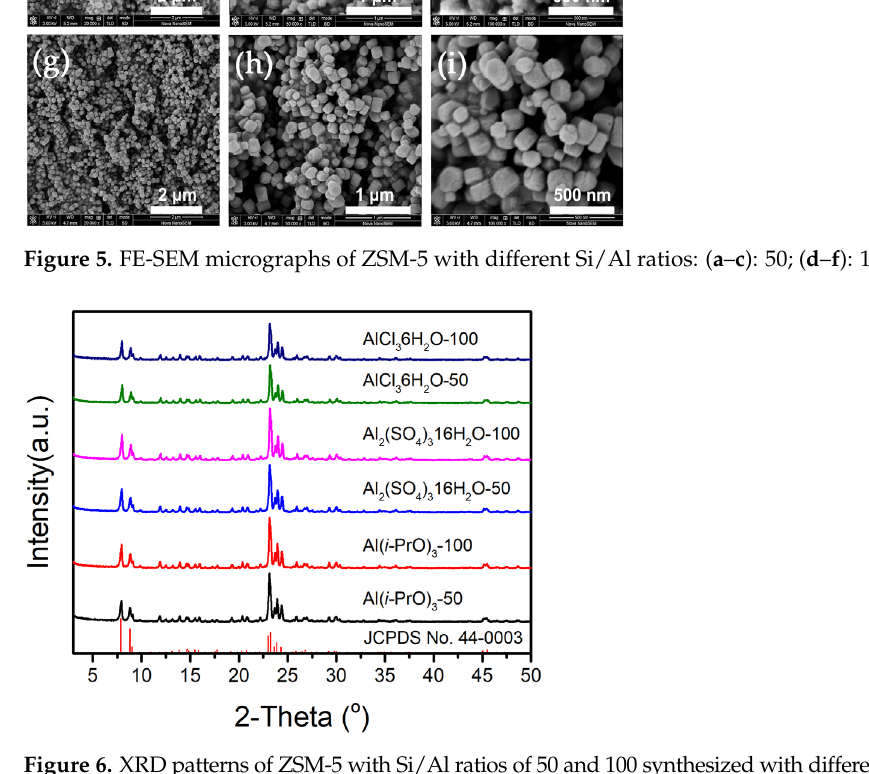
terized. TEM micrographs (Figure 11) of ZSM ‐ 5 ‐ 100 ‐ 200 indicated that spheroidal parti ‐ cles directionally accumulated in molten clusters with a size of about 33 nm in width and 70 nm in length. In addition, the black and white contrast indicated the presence of inter ‐ crystalline meso ‐ or macropores. Directional accumulation alignment and growth are of ‐ ten an indicator of the history of directional attachment growth.[29]. The textural proper ‐ ties of ZSM ‐ 5 samples were further obtained by measuring N 2 adsorption–desorption iso ‐ therms, as shown in Figure 10, and the corresponding calculated data are summarized in Table 1. When the relative pressure P/P 0 < 10 − 3 , the uptake curve of both samples exhibited a very steep rise owing to micropore filling. In addition, there was another jump at P/P 0 > 0.85 accompanying a hysteresis loop in the isotherm, which was attributed to the capillary condensation of N 2 molecules in the interlayer mesopores or macropores formed by the accumulation of primary particles. The isotherms had both type I and type IV character ‐ istics, indicating that the material contained both micropores and secondary meso ‐ or macropores simultaneously. The surface area was 508 m 2 g − 1 and 495 m 2 g − 1 for ZSM ‐ 5 ‐ 50 ‐ 200 and ZSM ‐ 5 ‐ 100 ‐ 200, respectively. In addition, the distributions of pore sizes also showed the existence of a large number of interlayers mesopores and macropores in ZSM ‐ 5 samples (Figure 11b). Compared with ordinary NaZSM ‐ 5 [30], ZSM ‐ 5 synthesized by phase transfer had a larger specific surface area, mainly accounting for the increase in the external surface area and mesopore volume, which is consistent with the SEM and TEM results.